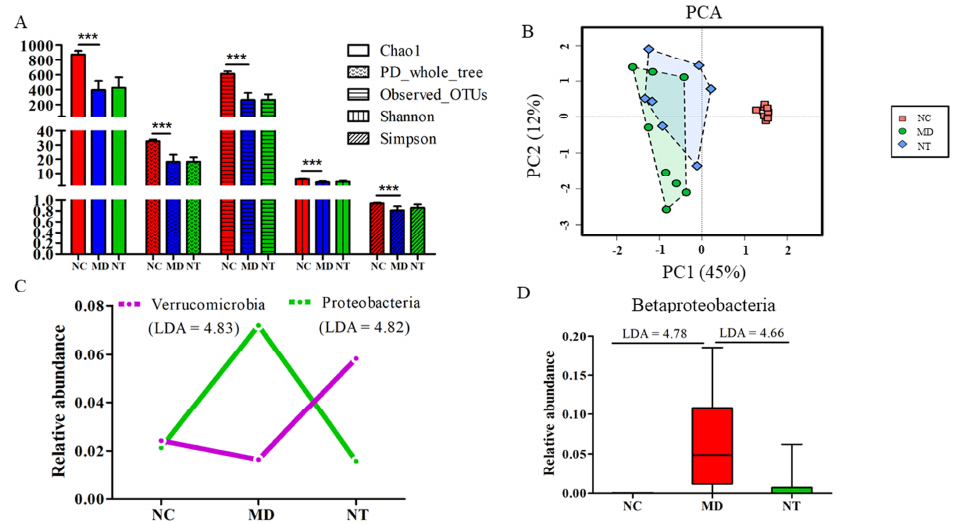
Figure 2. The modulatory effect of neoagarotetraose (NT) on the murine gut microbiome. NC: normal control mice. MD: DSS induced colitis mice. NT: DSS induced colitis mice supplemented with NT. ( A ) Alpha diversity indices impacted by DSS and NT supplementation. *** p < 0.01 based on